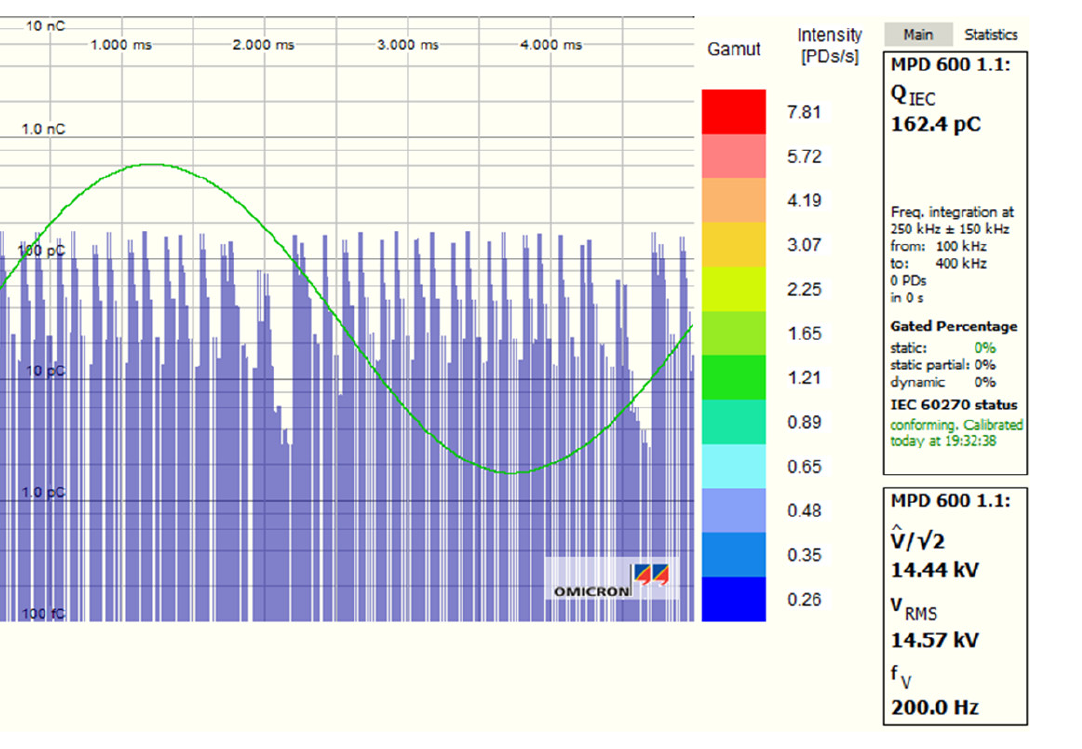
Figure 19. Experimental test results when the PWM converter was applied to the system.